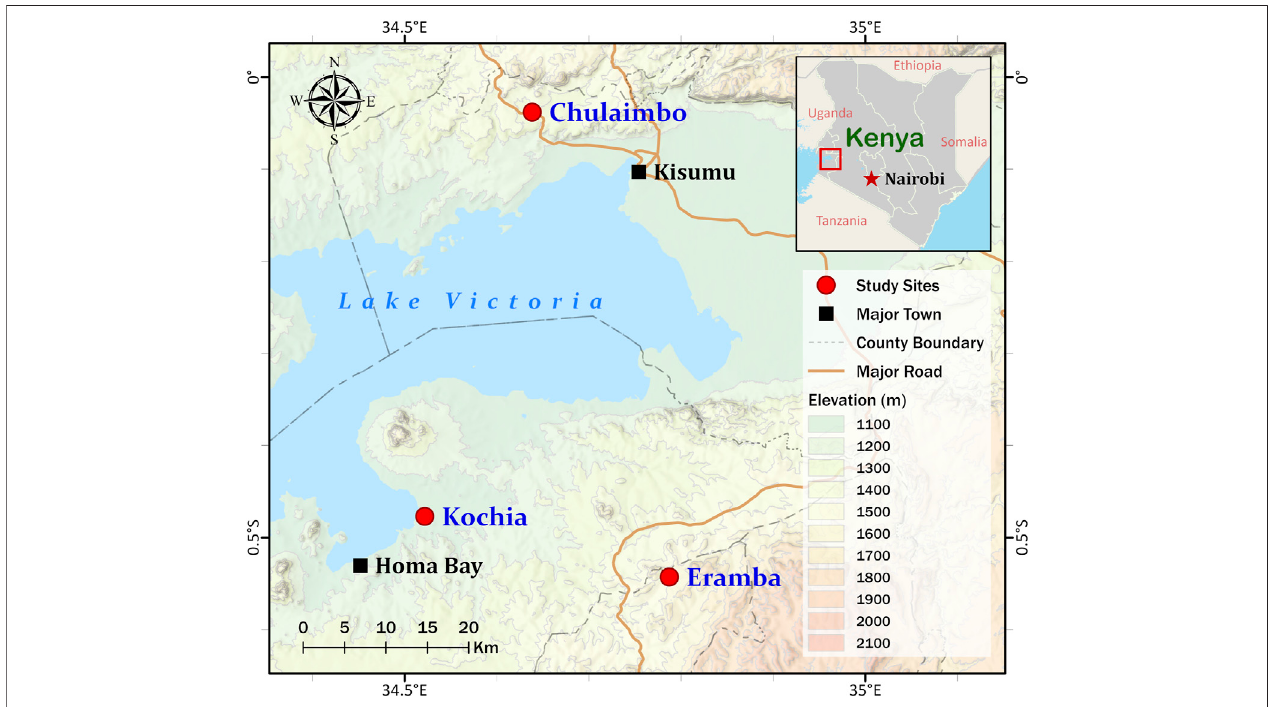
FIGURE1| MapshowingHomaBay(Kochia),Kisumu(Chulaimbo)andKisii(Eramba)studysitesinwesternKenya.Thesamplingpointsarerepresentedbythered circles on the map. This fi gure was prepared with ESRI ArcGIS Pro 2.8 with fi eld survey results and publicly available datasets. The map contains information from OpenStreetMap and OpenStreetMap 115 Foundation, which is made available under the Open Database